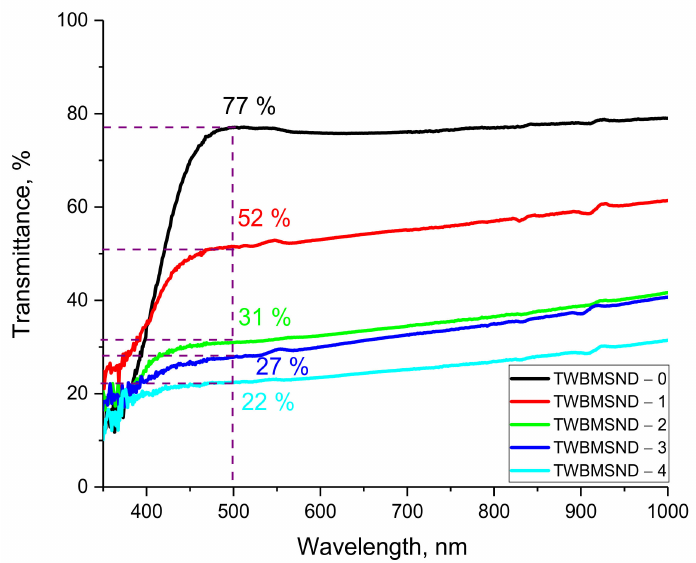
Figure 2. Graph of the optical transmission value depending on the wavelength for glasses with different concentrations of the CND dopant.